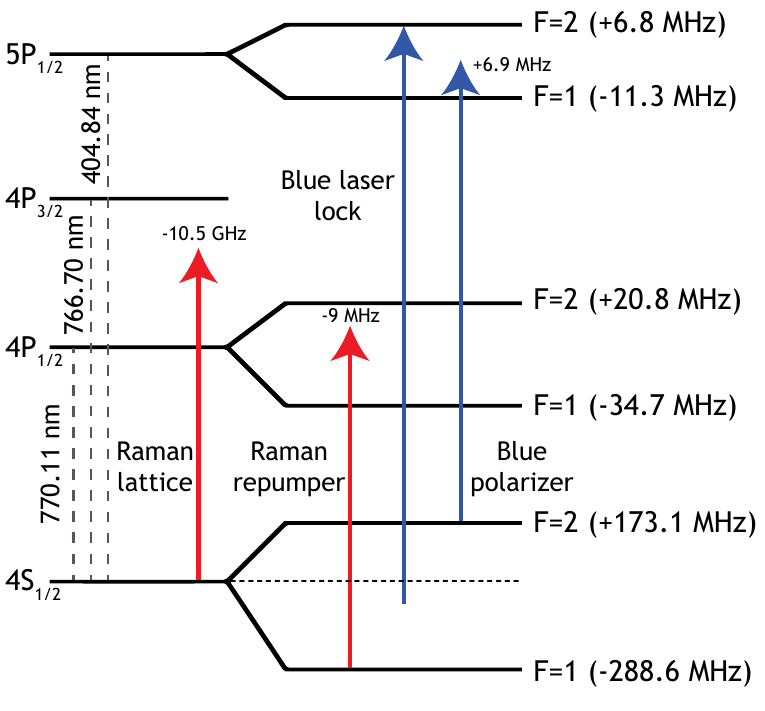
Figure 3: Energy level diagram with the hyperfine structure and the relevant transi- tions. For optimum performance, we use the Raman lattice laser 10.5 GHz red de- | F = 1 〉 tuned from the 4P state, the polarizer 6.9 MHz blue detuned from the 5P 3 / 2 1 / 2 | F = 2 〉 state. The ground- state, and the repumper 9 MHz red detuned from the 4P 1 / 2 | F = 2 〉 transition to which the 404-nm laser is locked is state crossover to the 5P 1 / 2 also